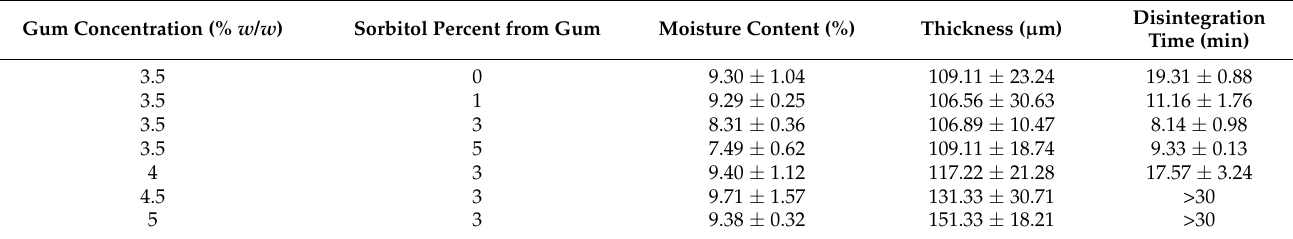
Table 2. Moisture content, film thickness, and disintegration time of different printing substrate formulations. Gum Concentration (% w / w